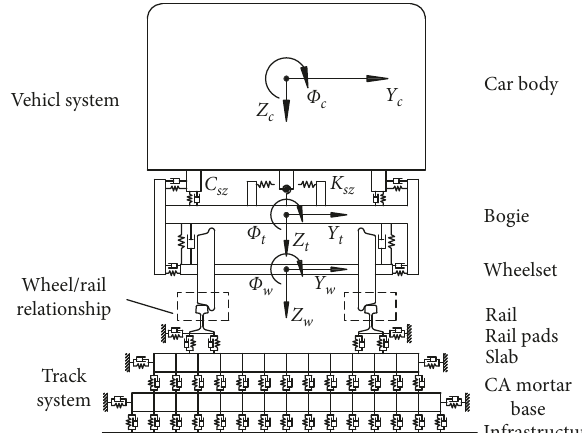
Figure 2: Vehicle-track coupled dynamics